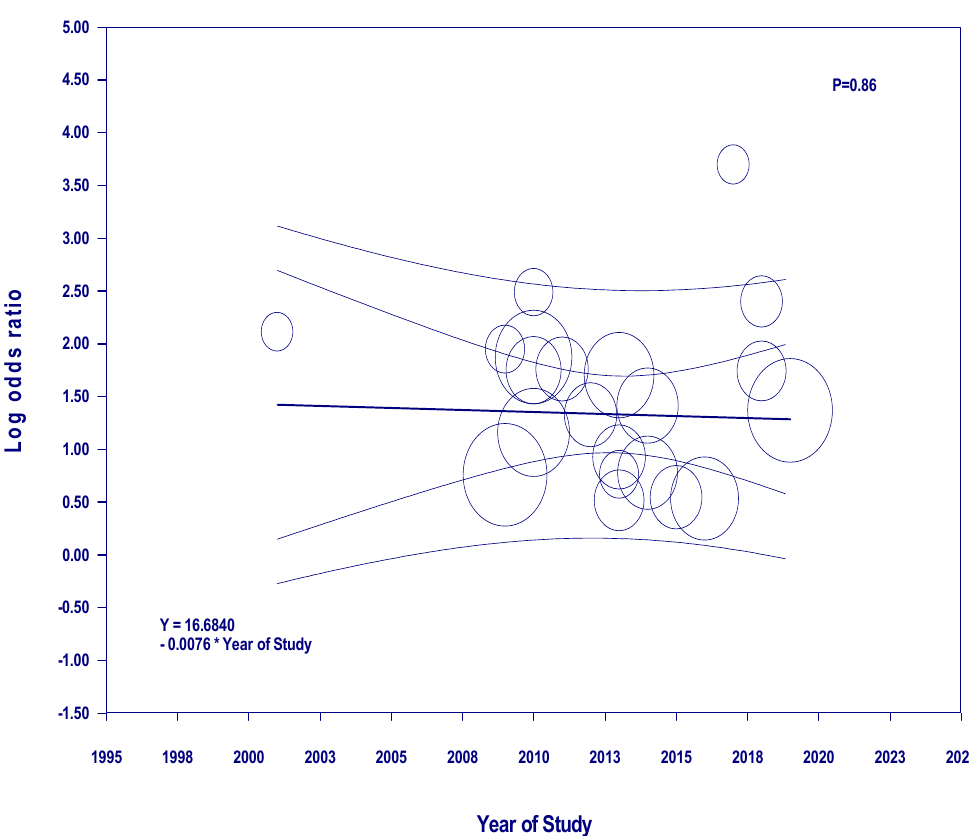
Figure 6. Meta-regression analyses showed that year of the study did not significantly affect hospital mortality among patients receiving ECMO with AKI requiring RRT ( p = 0.86). The solid black line depicts the weighted regression line based on variance-weighted least squares. The inner and outer lines represent the 95%CI and prediction interval encompassing the regression line. The circles indicate log event rates in an individual study.